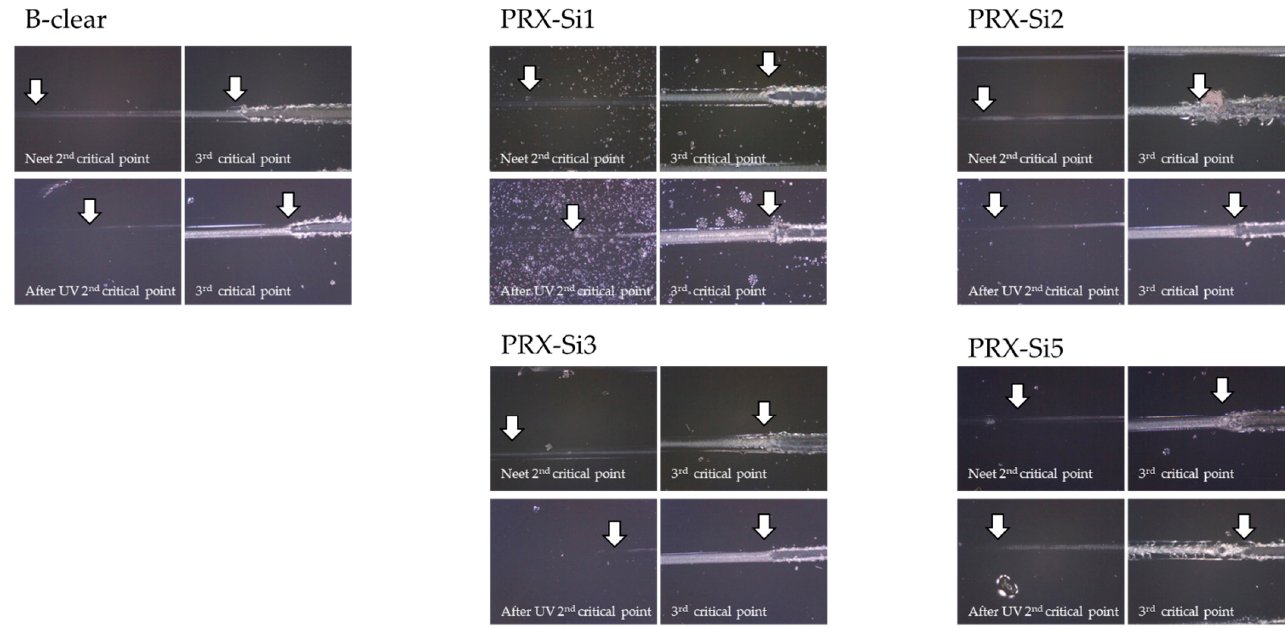
Figure 12. Variation in scratch damage mechanisms for second and third critical loads under UV photodegradation con- ditions.